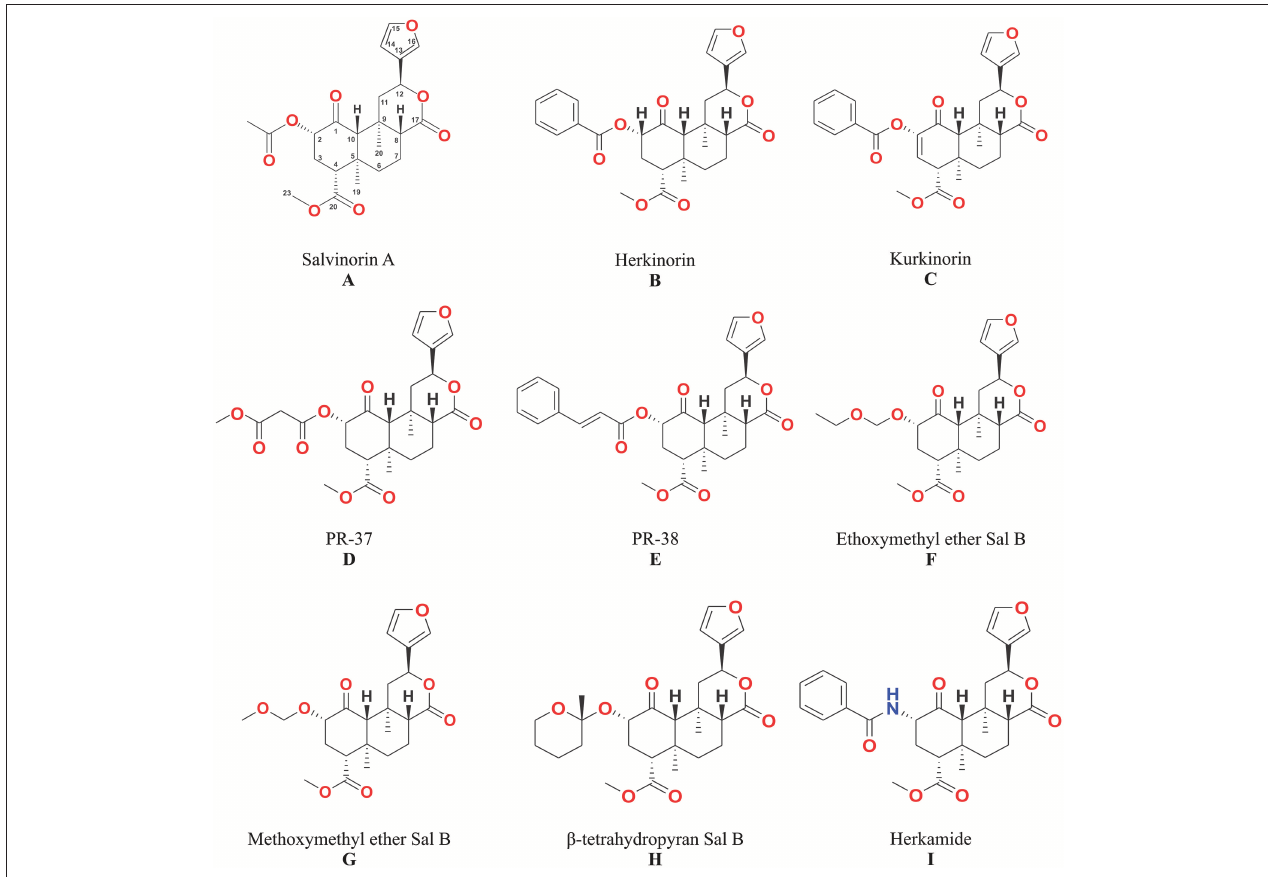
FIGURE 3 | The structures of salvinorin A (A) and its analogs (B–I) .